Question: Give a one-sentence summary of this figure.
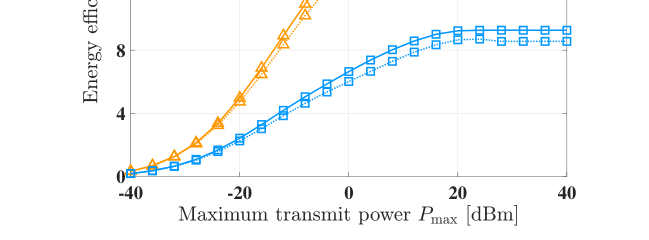
Answer: Comparison of the energy efficiency versus the maxi- mum transmit power budget Pmax in the RHS-based beam- forming scheme, with the effect of HWI is considered or ignored in the beamforming algorithms.